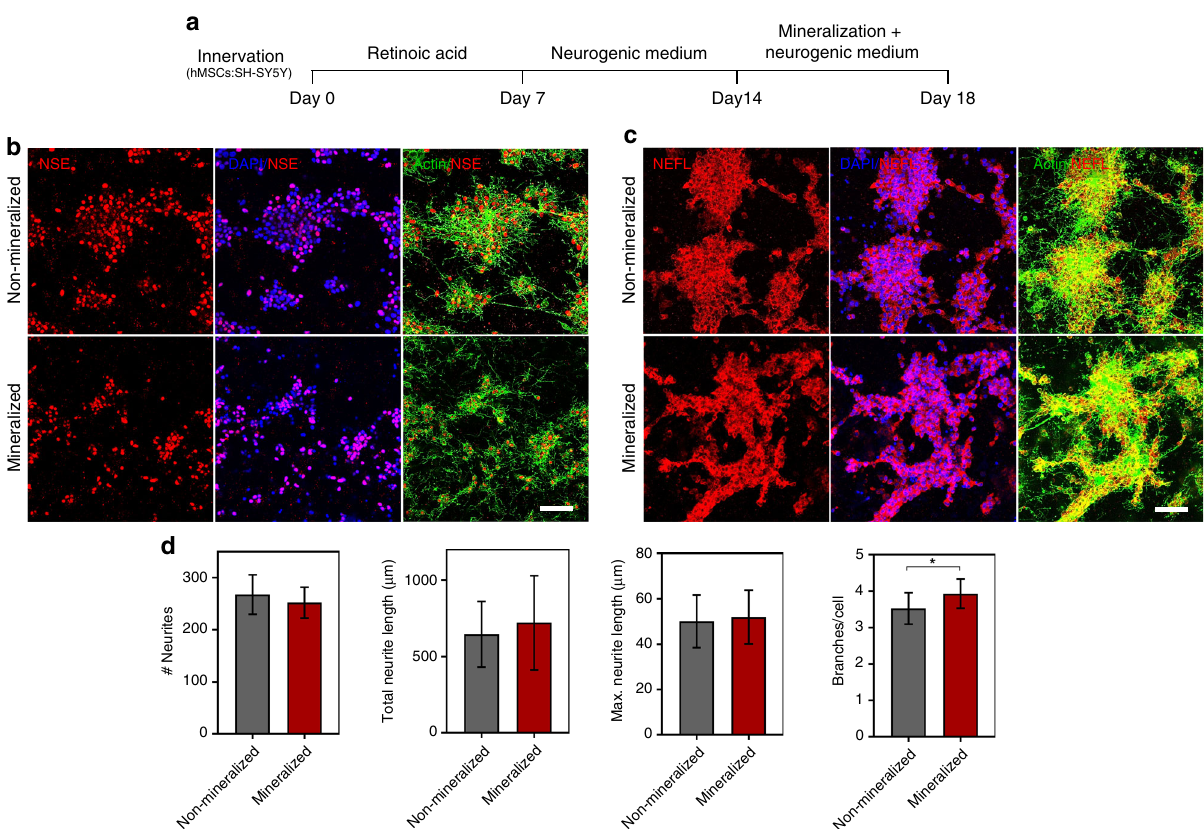
Fig. 5 Innervation of mineralized cell-laden collagen. a Timeline for the generation of innervated and mineralized collagen constructs. Human SH-SY5Y neuroblastoma cells were co-encapsulated with hMSCs (4:1) in non-mineralized and mineralized hydrogels, after 14 days of differentiation. For the fi rst 7 days, the cells were treated in DMEM/F-12 basal medium supplemented with 1% FBS and 10 µ M all- trans retinoic acid (RA), followed by an additional 7 days of culture in Neurobasal-A medium containing 1% (v/v) L -glutamine, 1× B-27 supplement, 50 ng/mL human BDNF, and 10 µ M RA. Subsequently, matrix mineralization was triggered by switching the neurobasal medium for the mineralizing medium for another 3 days. The fully differentiated neuronal cells within the mineralized constructs were con fi rmed by immunostaining with antibodies against Neuron-speci fi c enolase (NSE) and Neuro fi lament light (NEFL). Cell nuclei were counterstained with DAPI (blue) and cytoskeletal actin was stained with Alexa Fluor 488 phalloidin (green). b , c Representative immuno fl uorescence images showing the expression of NSE and NEFL in non-mineralized and mineralized constructs. Both the neuronal differentiation markers had similar expression levels in mineralized and non-mineralized groups. Scale bar: 50 µ m. d Imaris Filament Tracer module was used to quantify the morphological parameters of the differentiated SHSY-5Y cells in non-mineralized vs. mineralized constructs. Quanti fi cation of the number and length of neurites indicate no signi fi cant difference between non-mineralized and mineralized groups, whereas the number of branches and branch points was higher in the mineralized groups. Data are represented as Mean ± SD, * p < 0.05, Student ’ s t -test ( N = 4). Source data are provided as a Source Data fi (NEFL), which were visible in both mineralized and non- mineralized constructs at comparable levels (Fig. 5b, c). Quanti- fi cation of number of neurites, total neurite length, and maximum neurite length were also statistically comparable between miner- alized and non-mineralized hydrogels. The number of branches and branch points per cell, on the other hand, were signi fi cantly higher for cells embedded in the mineralized constructs (Fig. 5d).